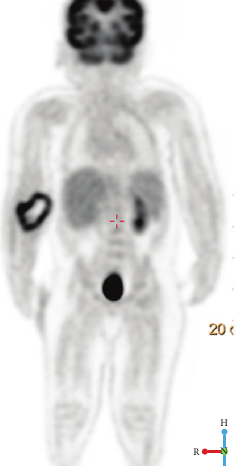
Figure 3: Whole body FDG PET imaging reveals a FDG-avid mass in the right forearm with central photopenia corresponding to the mass within the ventral aspect of the proximal forearm.